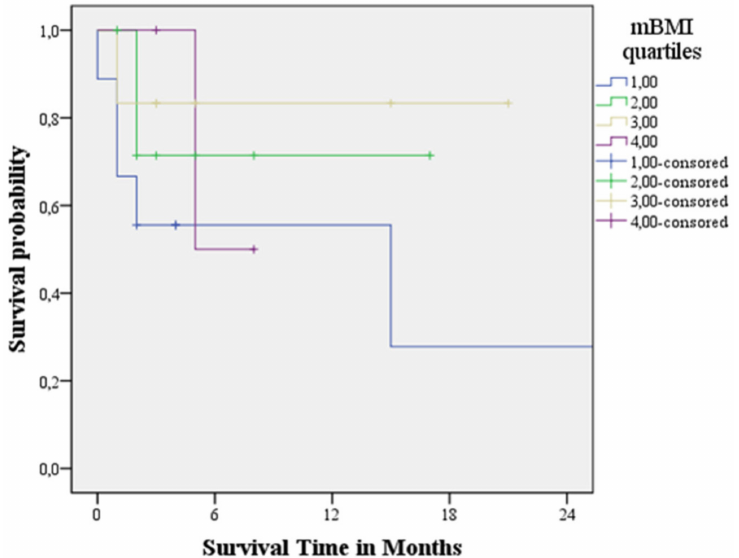
Figure 2. Kaplan-Meier survival curve analysis of cardiovascular mortality in AL group across the quartiles of the modified Body Mass